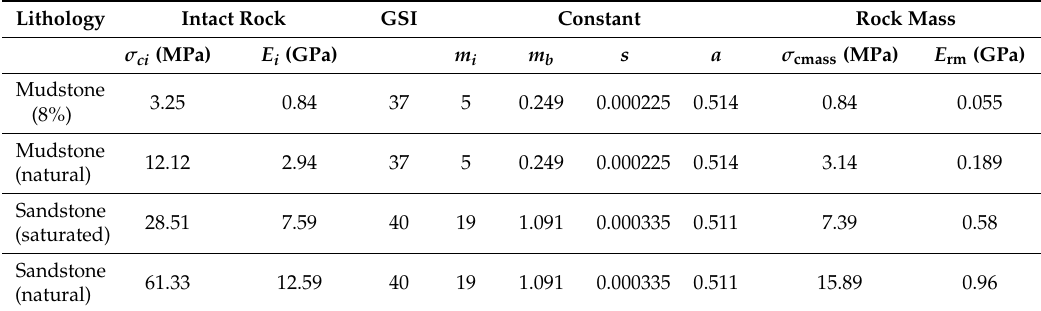
Table 3. Intact rock properties and rock mass